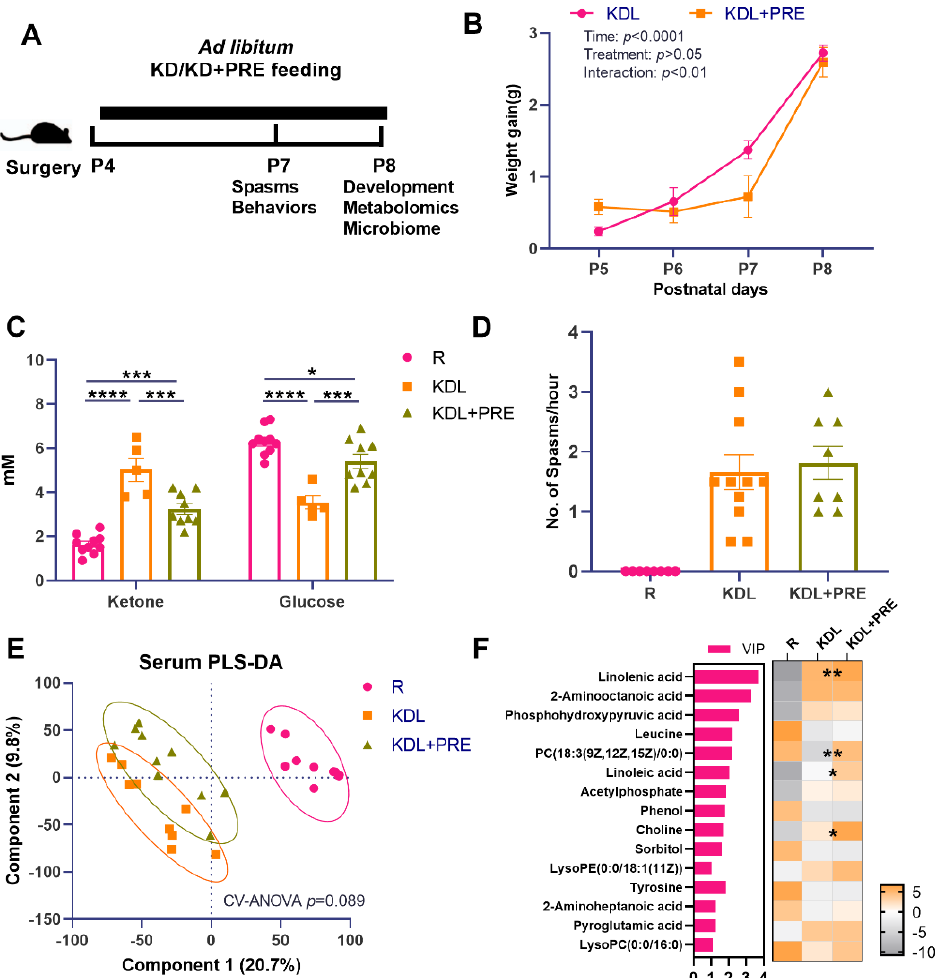
Figure 1. Effects of prebiotic inclusion on body mass, seizures, and systemic metabolism. ( A ) The experimental design. ( B ) Body weight gain. ( C ) Blood ketone and glucose concentrations. ( D ) Spasms frequency. ( E ) PLS-DA analysis of serum metabolites. ( F ) Discriminant metabolites with p < 0.05 and VIP > 1 in the serum. In the heatmap, * p < 0.05, ** p < 0.01 comparing KDL vs. KDL+PRE.